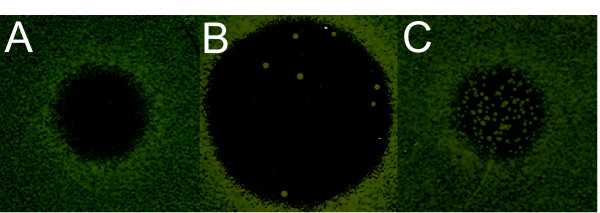
Halo test for α-factor based growth inhibition. Yeast strains (OD600 = 1) were plated on YPD plates and 1000 pmol of α-factor was spotted. The pictures are taken after 48 hours of incubation at 30°C. Strains: A: Wild type BY4741 (MATa his3Δ1 leu2Δ0 met15Δ0 ura3Δ0), B: sst2Δ, C: gas2Δ.